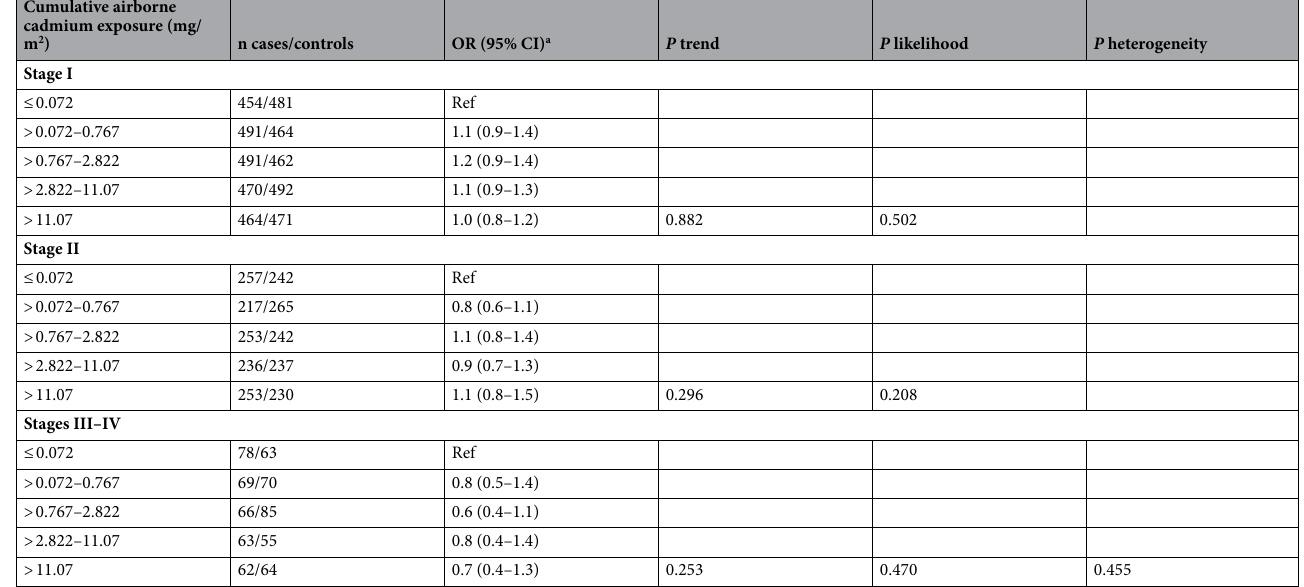
Table 2. Odds ratio and 95% confidence intervals (OR, 95% CI) for the association of quintiles of the cumulative airborne cadmium exposure with risk of breast cancer according to breast cancer stage in